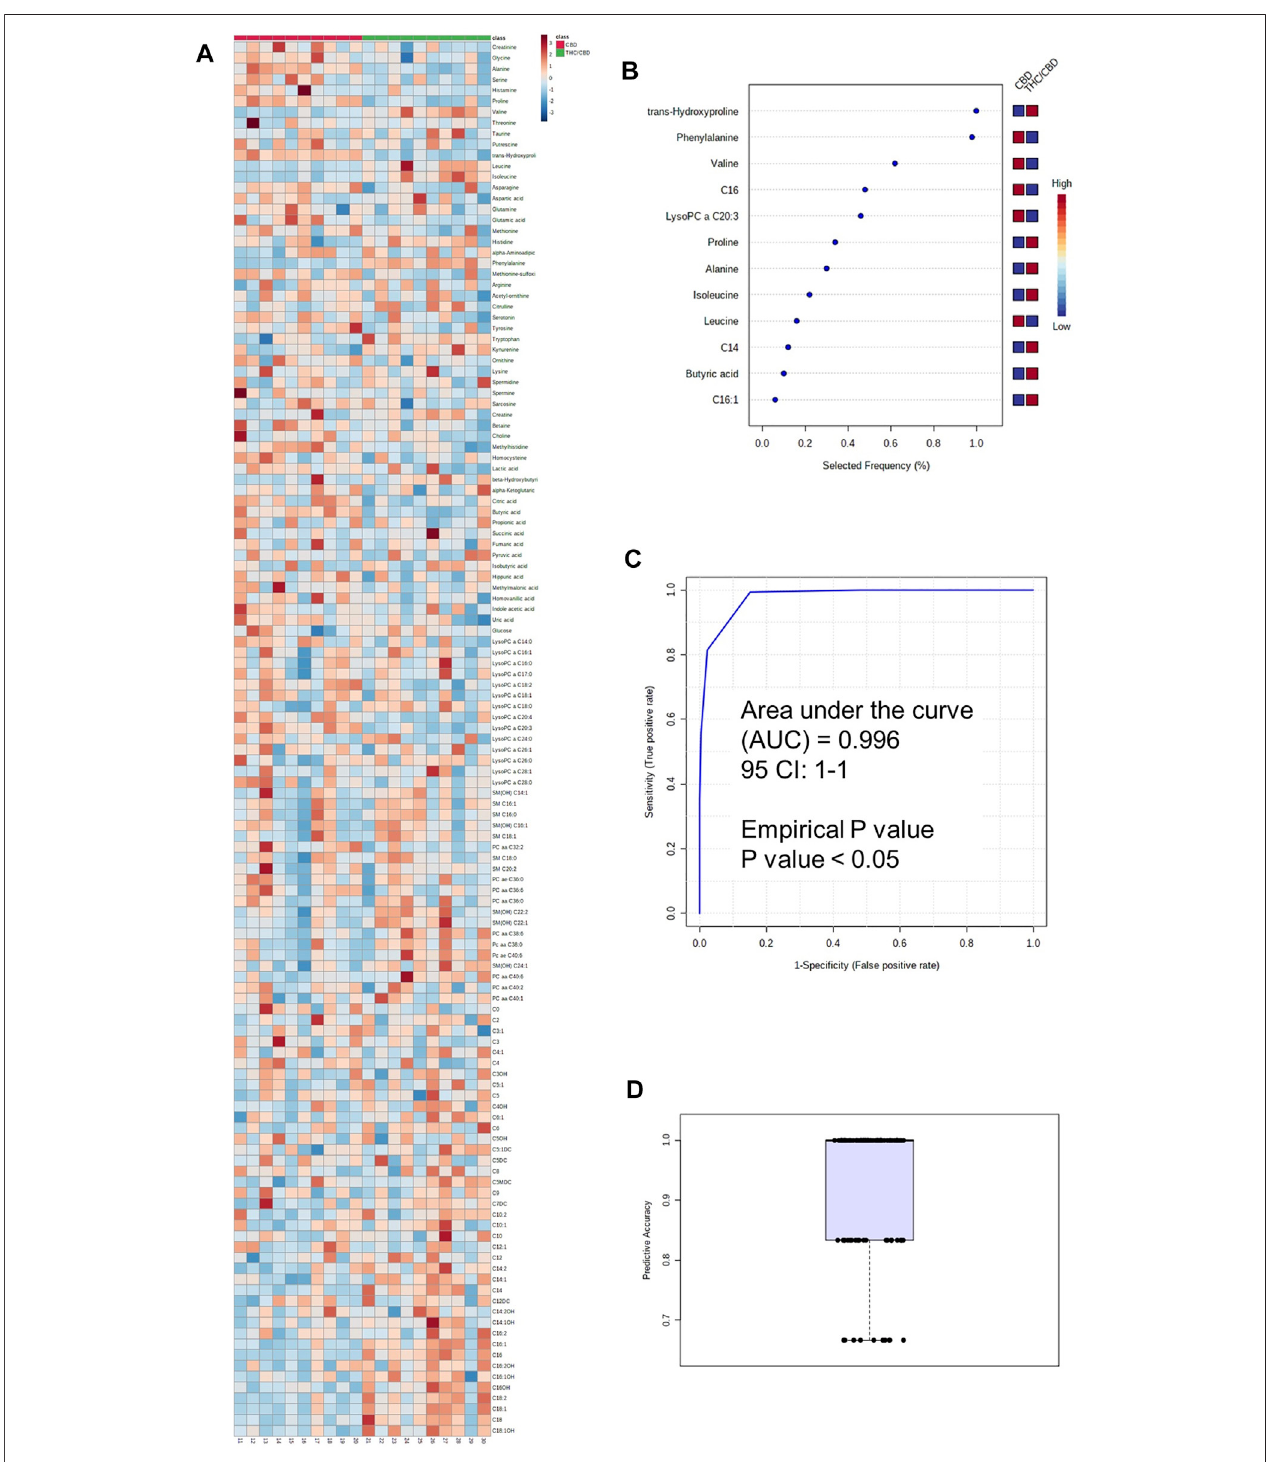
FIGURE 3 | Metabolomic differences between full-spectrum cannabis extract and broad-spectrum cannabis extract. (A) Heat map of metabolomic differences between full-spectrum cannabis extract and broad-spectrum cannabis extract groups. Heat maps were generated with the concentrations of potential candidate metaboliteswithunivariateanalysis.Similarmetaboliteswerearrangedtogetherforuseinpathwayanalysisthroughintuitivepatterndiscovery.Theheatmapdisplaysan increaseineach metaboliteinrelative concentration asred colorandadecrease inametaboliteasblue color.Themetabolitesarelistedat theleftsideofeach row, andthesubjectsareshownatthebottomofeachcolumn. (B) Rankofthedifferentmetabolites(thetop12)identi fi edbythePLS-DAaccordingtotheselectedfrequency